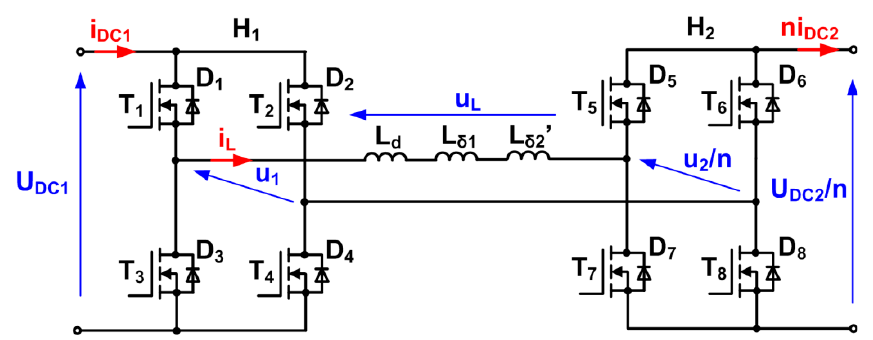
Figure 2. Equivalent circuit of the single-phase DAB converter.